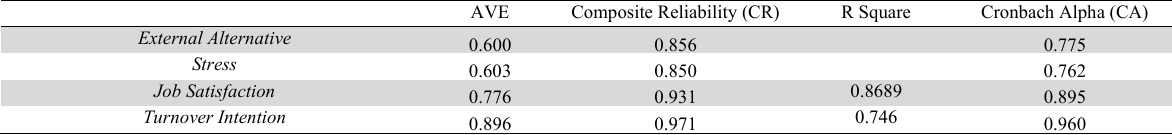
R-Square and Cronbachs Alpha